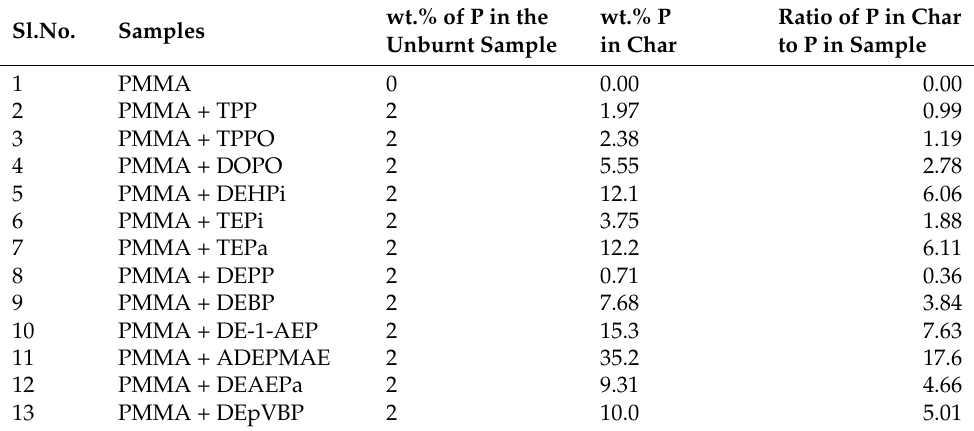
Table 2. Phosphorus contents of the unburned samples and char residues of PMMA-based materials.